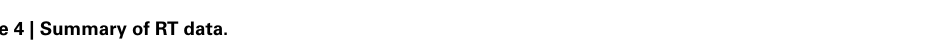
Table 4 | Summary of RT